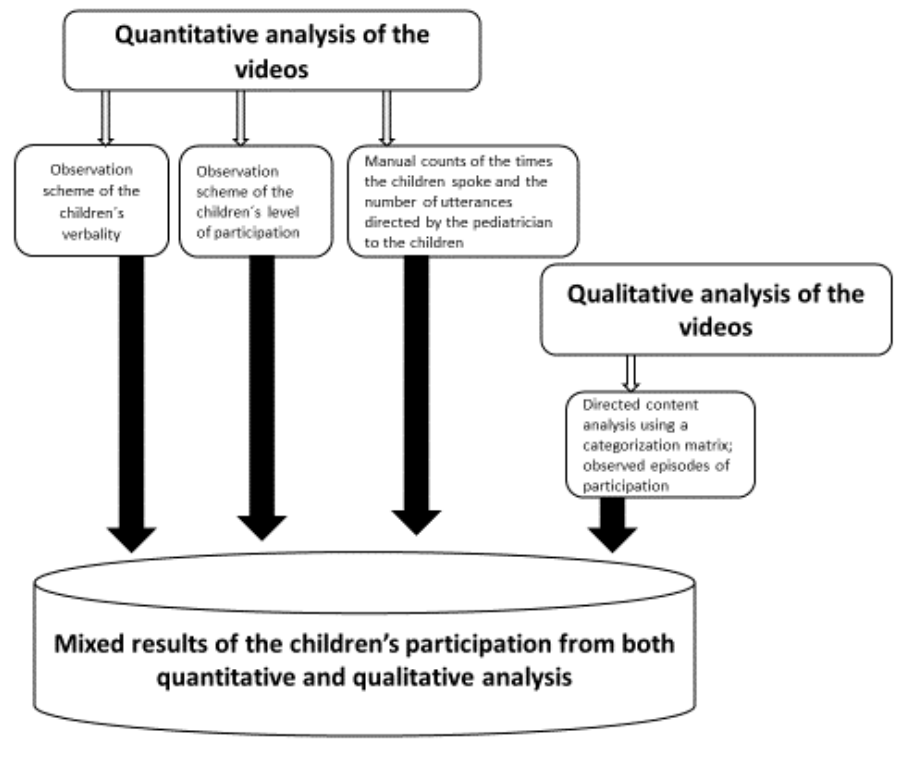
Figure 2. Processes for quantitative and qualitative